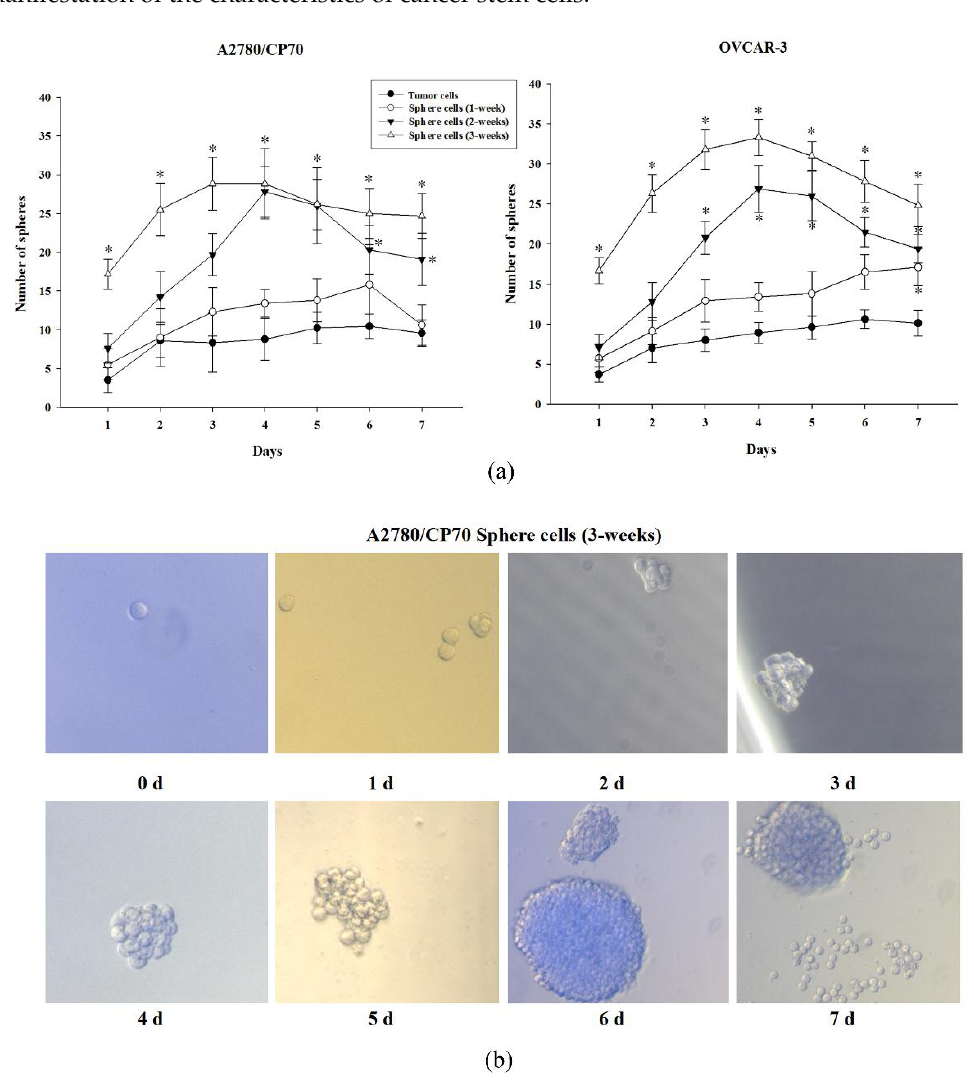
Figure 2. Sphere cells from A2780/CP70 and OVCAR-3 cell lines possess the stemness properties. ( a ) both A2780/CP70 and OVCAR-3 sphere cells had higher capacities in sphere formation compared to tumor cells; ( b ) the spheroidal morphology observed under a light microscope after culturing in serum-free medium (A2780/CP70 sphere cells 3-weeks) (200 × ). Data was expressed as number of spheres and shown as mean ± SD ( n = 6), * = p ≤ 0.05, significant difference compared with tumor cells at the same time.